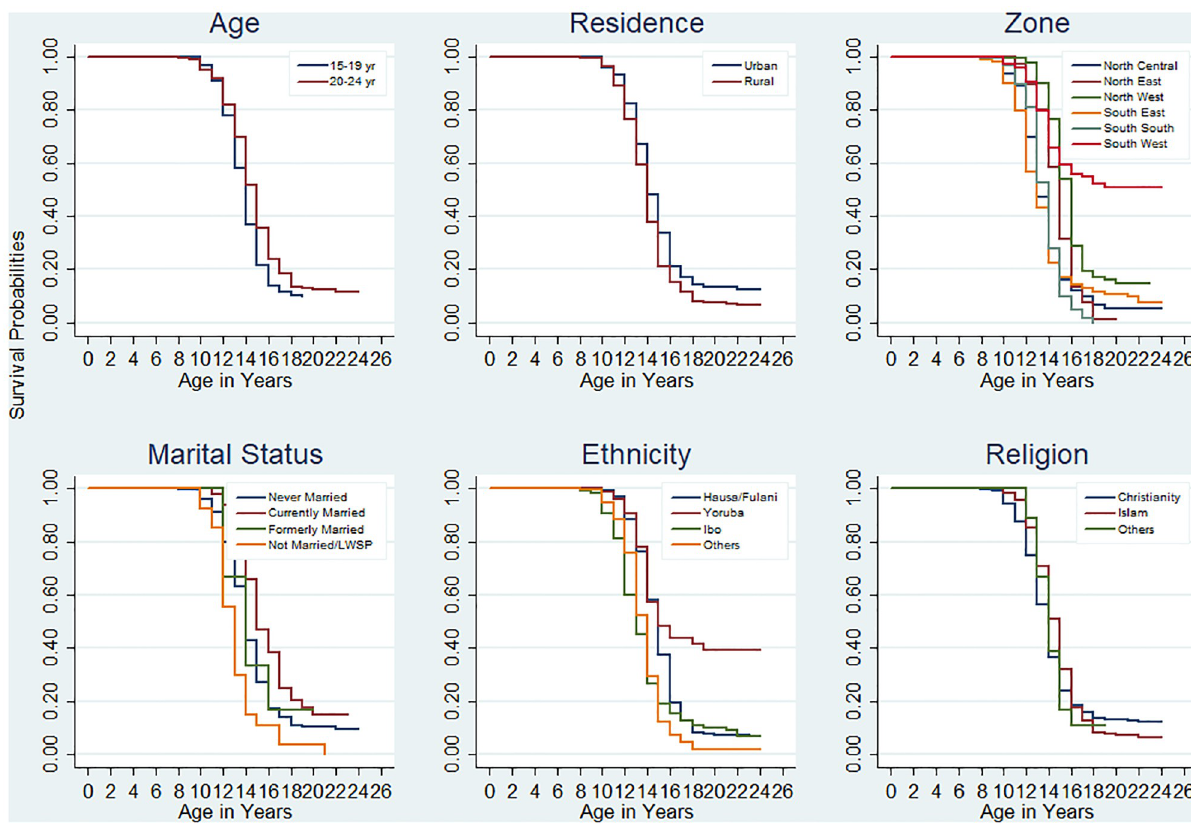
Fig 3. Survivorship curves showing probabilities of developing pubic hair at different ages by selected characteristics of females.